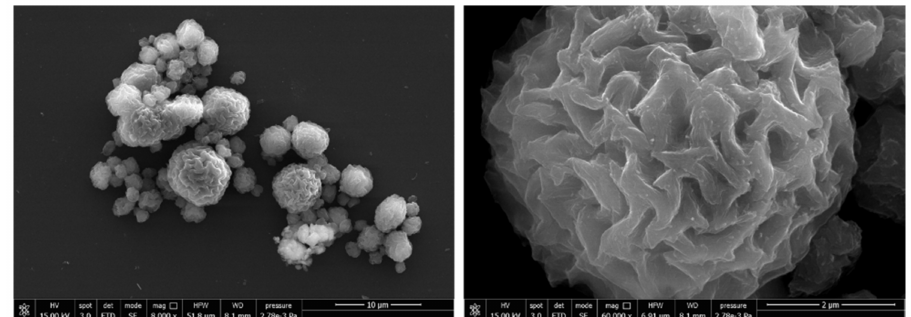
Figure 8. Microparticles of chitin nanofibrils spray dried using poly(ethylene